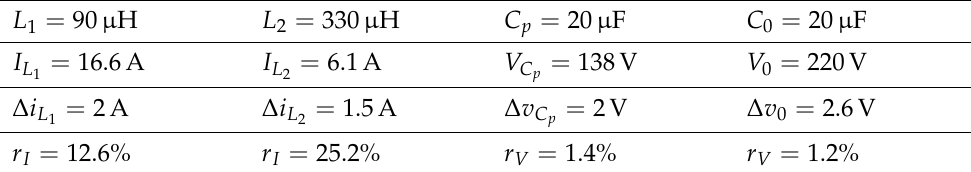
Table 3. Parameters of the proposed